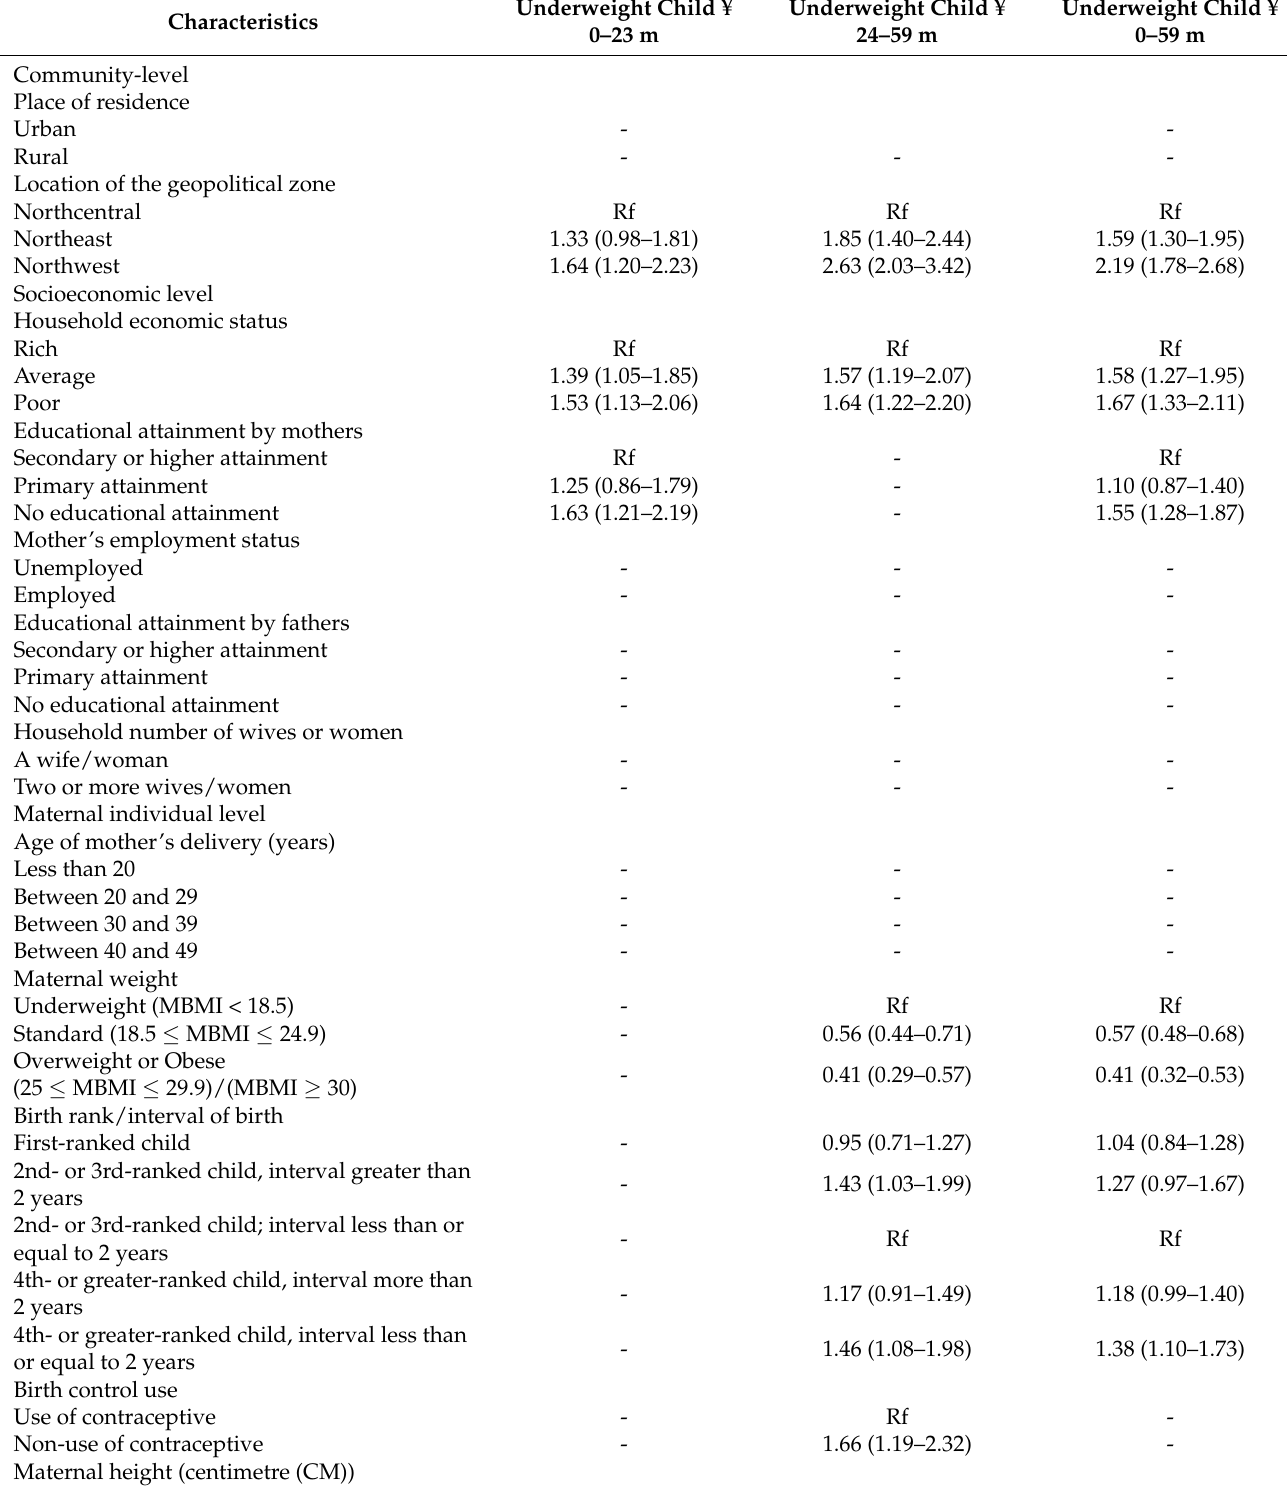
Table 2. Adjusted odds ratios for characteristics significantly related to underweight among 0–23